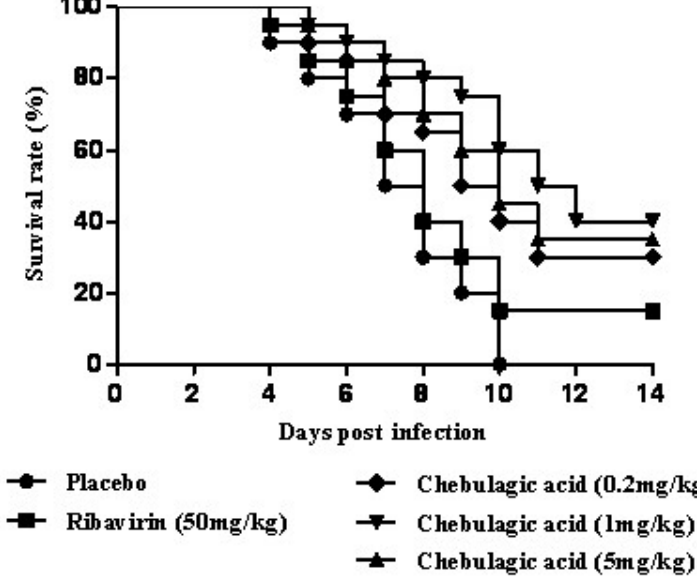
Figure 3. Chebulagic acid treatment reduced the mortality of EV71-infected mice. Survival rates of the EV71-infected mice treated with the placebo, ribavirin (50 mg/kg) and chebulagic acid (0.2, 1 and 5 mg/kg) were recorded at 14 dpi ( n =